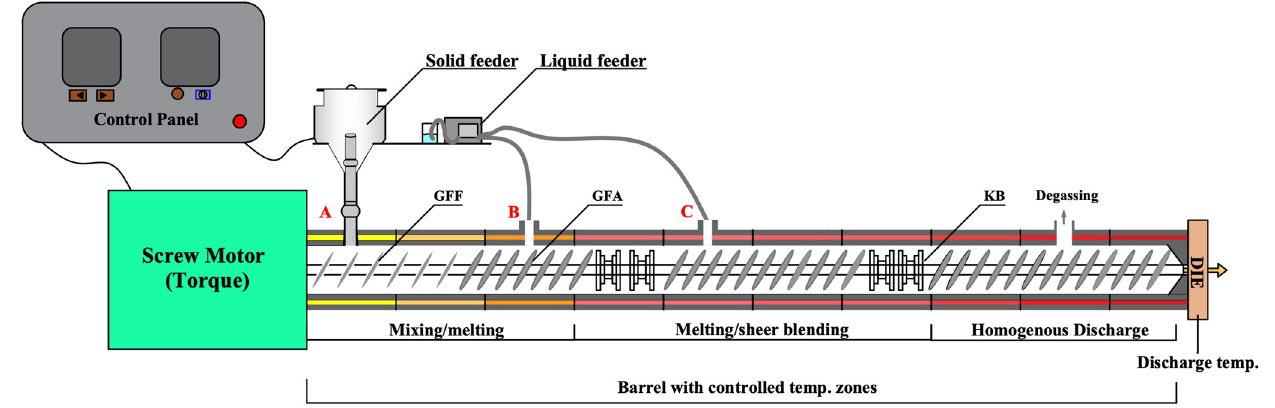
Figure 1. Schematic set-up of the Twin Screw Extruder for Pharma: (A) Solid feeding zone; (B) Liquid feeding zone 1; (C) Liquid feeding zone 2. GFF: conveying elements with an enlarged free volume; GFA: conveying; KB: kneading elements.